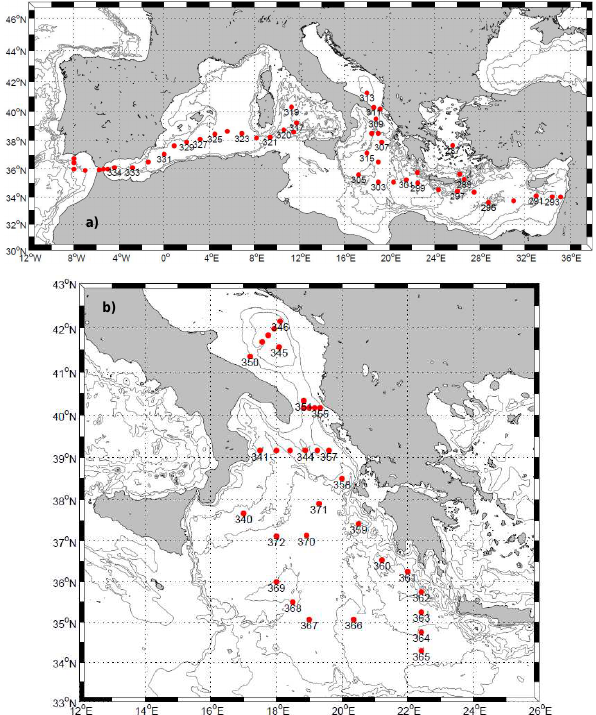
Figure 1. (a) CTD stations (red dots) of METEOR cruise M84-3 during April 2011. Depth contour lines are 200, 500, 1000, 2000, 3000, 3500 and 4000m. (b) CTD stations (red dots) of POSEIDON cruise P414 during June 2011. Depth contour lines are 200, 500, 1000, 2000, 3000, 3500 and